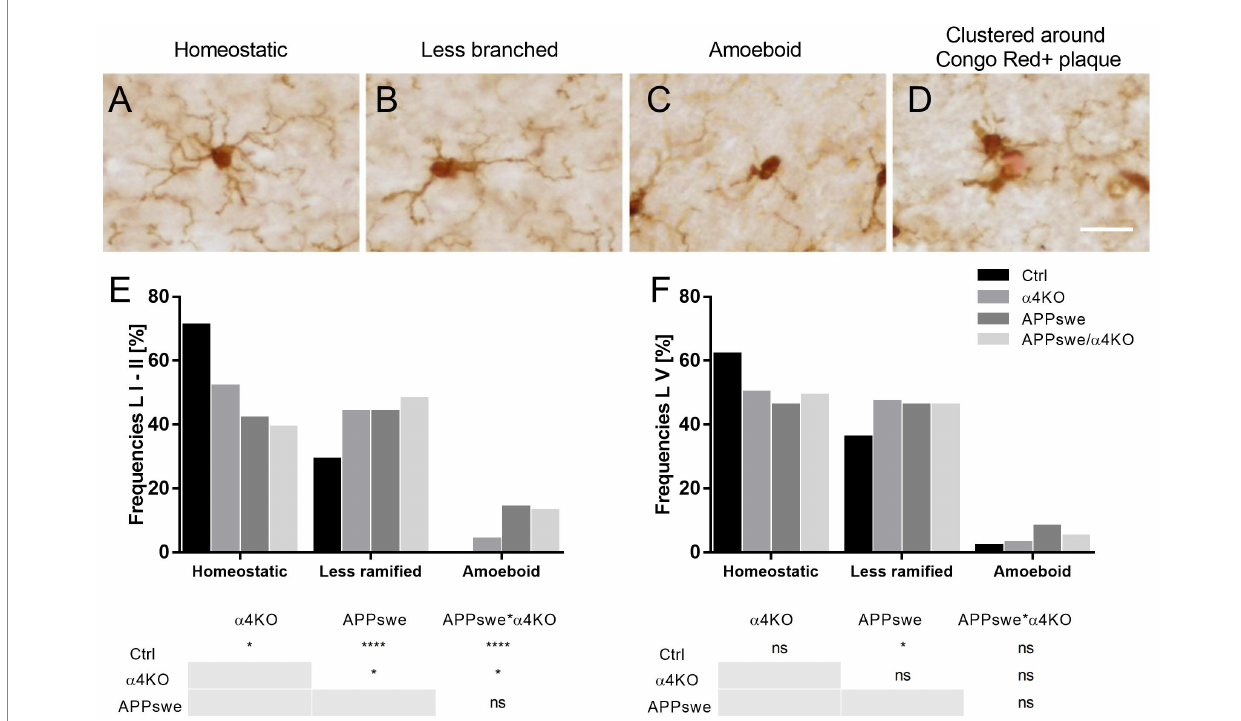
FIGURE 6 Classification of morphological phenotypes of microglial cells in 5 mo mice. (A–D) Representative images of homeostatic (A) , less ramified (B) , isolated amoeboid (C) or clustered around Congo Red+ plaque (in red) Iba1+ microglia. Scale bar = 40 μ m. (E,F) Quantitative analysis of Iba1+ cell frequency in layer I–II (E) and layer V of sCtx of 5 mo mice. Frequencies are shown as % by each group and compared by Chi-square test, * p < 0.05, **** p < 0.0001. L I–II, V, layers I–II,